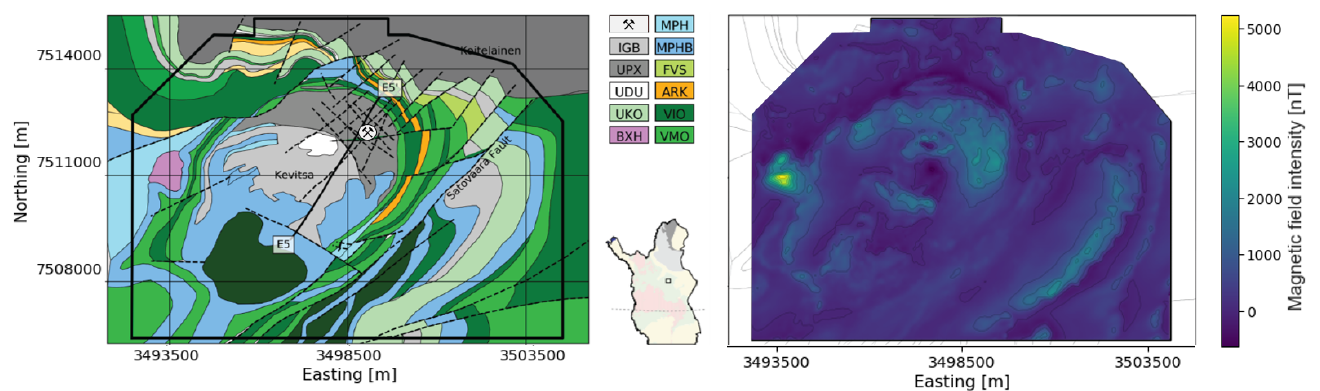
Figure 3. ( Left ) Geological surface map of the Kevitsa deposit with the described units (after Fournier [46]), and the location of Kevitsa in Finland and in the Central Lapland greenstone belt (CLGB) (in green). ( Right ) Original airborne magnetic data with the measured total magnetic